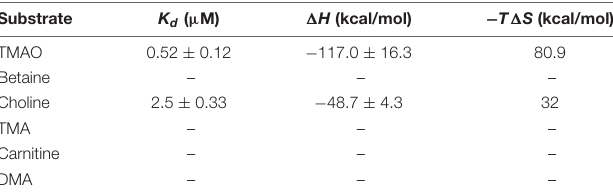
TABLE 1 | Thermodynamic parameters determined by ITC measurements. Substrate